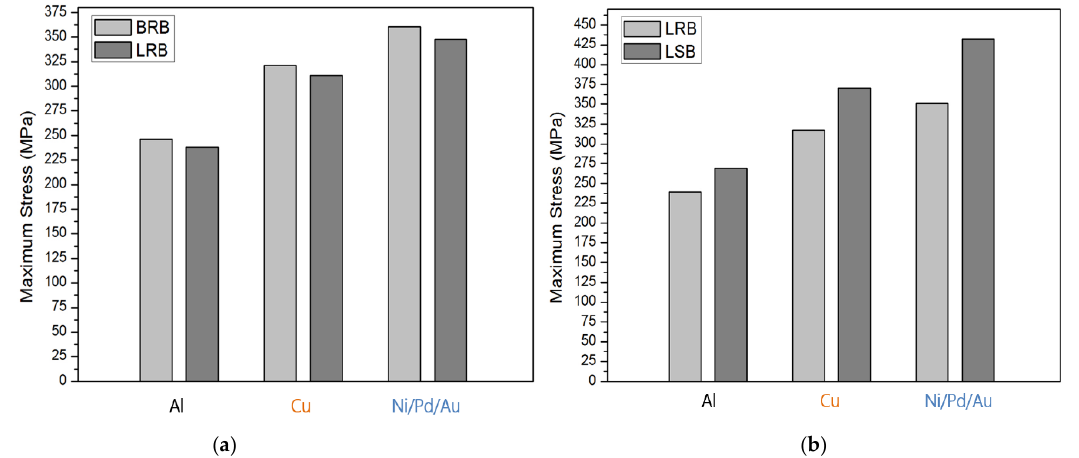
Figure 10. Comparison of the maximum stress of 10-μm thick specimens: ( a ) BRB and LRB; ( b ) LRB and LSB.